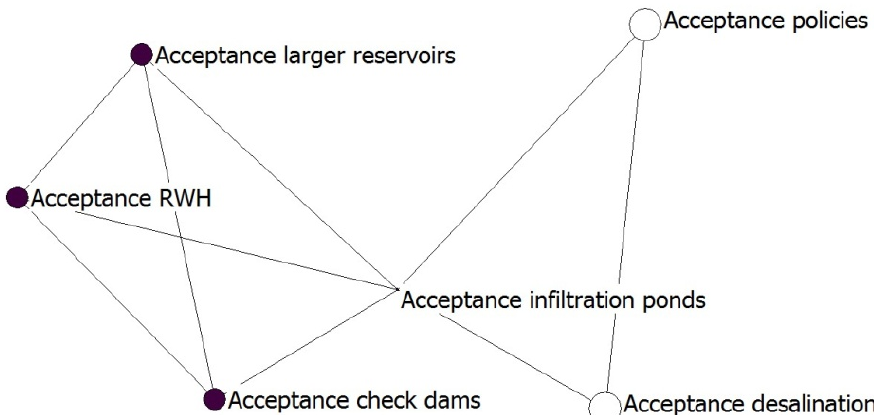
Figure 3. Pair-wise tests for differences in